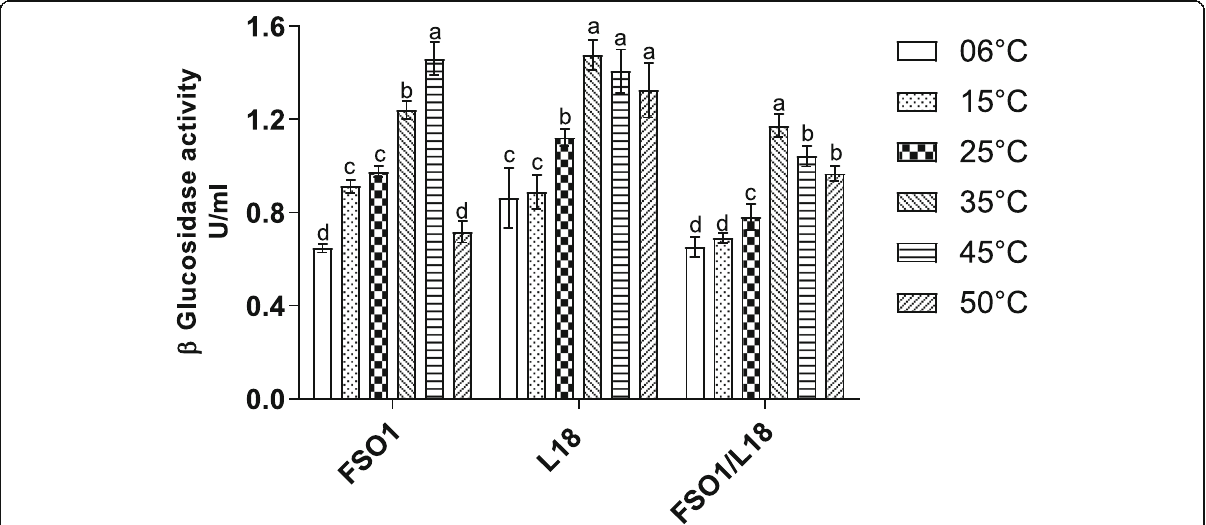
Fig. 12 Residual activity of β -glucosidase after 7 days of cultures at 30 °C for pure (FSO1, L18) and combined (FSO1/L18) cultures in modified MRS broth containing oleuropein (1%) as a sole carbon source at different final temperatures. (Legend: FSO1: L. plantarum , L18: C. pelliculosa